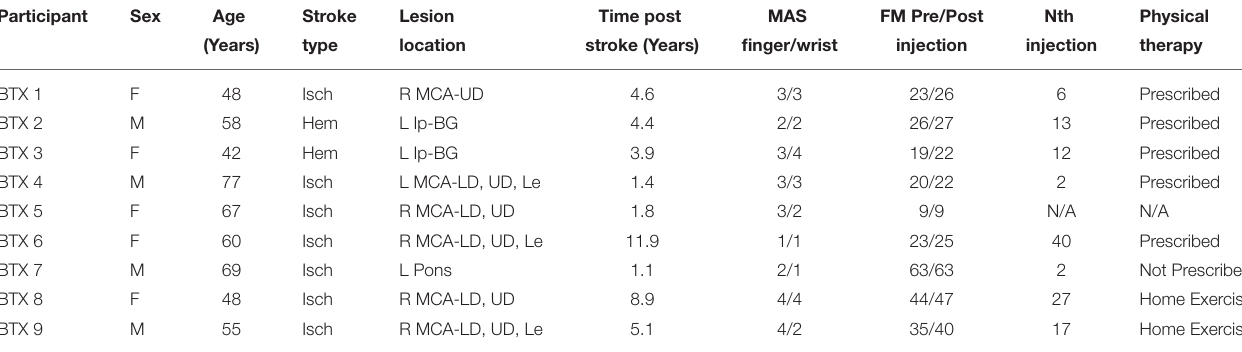
MCA, middle cerebral artery; LD, Lower Division; UD, Upper Division; Le, Lenticulostriate; Ip, Intraparenchymal; BG, Basal Ganglia; R, Right; L, Left; Isch, Ischemic; Hem, Hemorrhagic; Note: information regarding the number of injections and details of physical therapy for participant number 5 was not available due to transfer between centers.